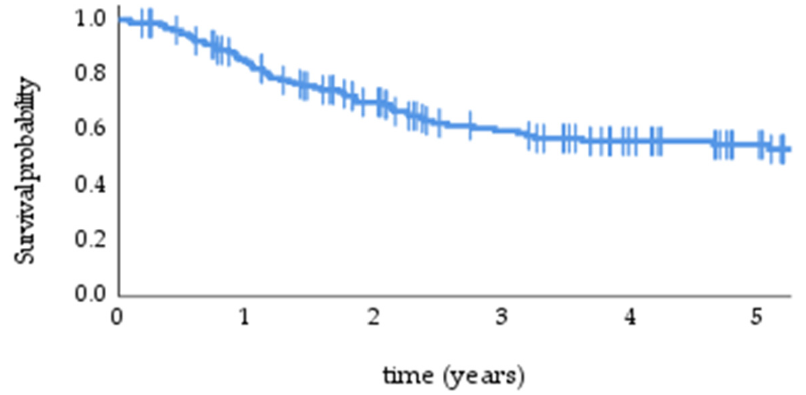
Figure 2. Disease-free survival in overall study population ( A ), stratified by gender ( B ) and lymph nodes (LN) involvement ( C ).